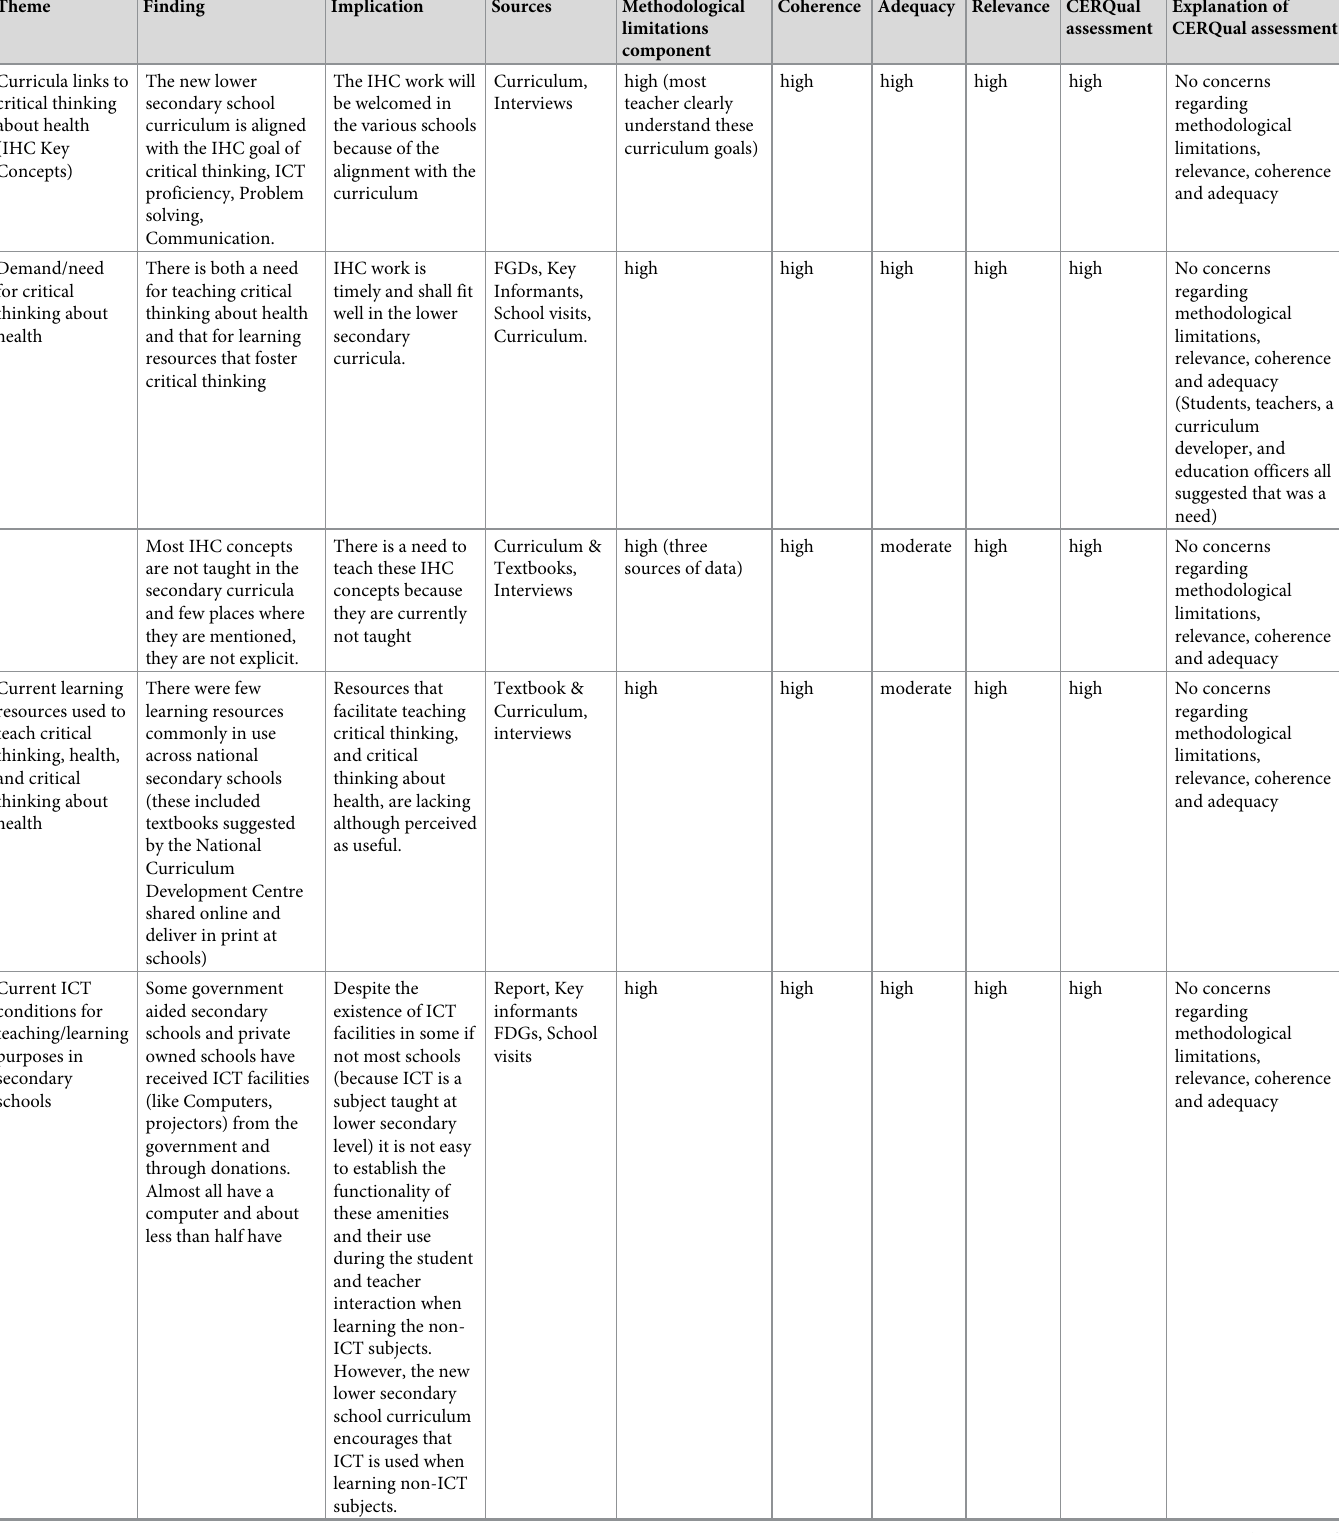
Table 6. CERQual summary of the key findings from the documents analysis, FDGs, Informant interviews and School